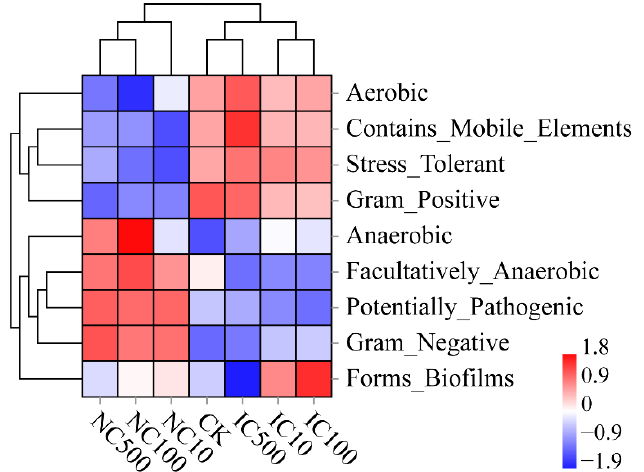
Figure 8. Hierarchical clustering heatmap of predicted bacterial phenotypic traits by BugBase. The heatmap is based on the standardized phenotypic trait abundance data. Warmer color (red) indicates a higher phenotypic trait abundance, while colder color indicates a lower phenotypic trait